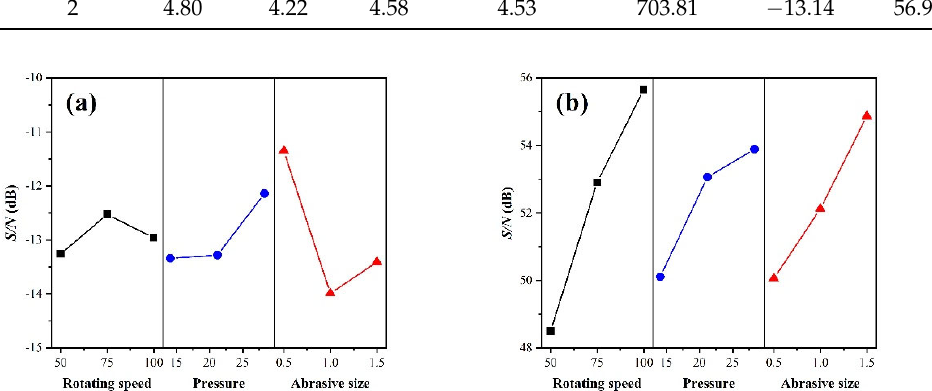
Figure 2. Plots of the control factor effects. ( a ) Sa ; ( b ) MRR.